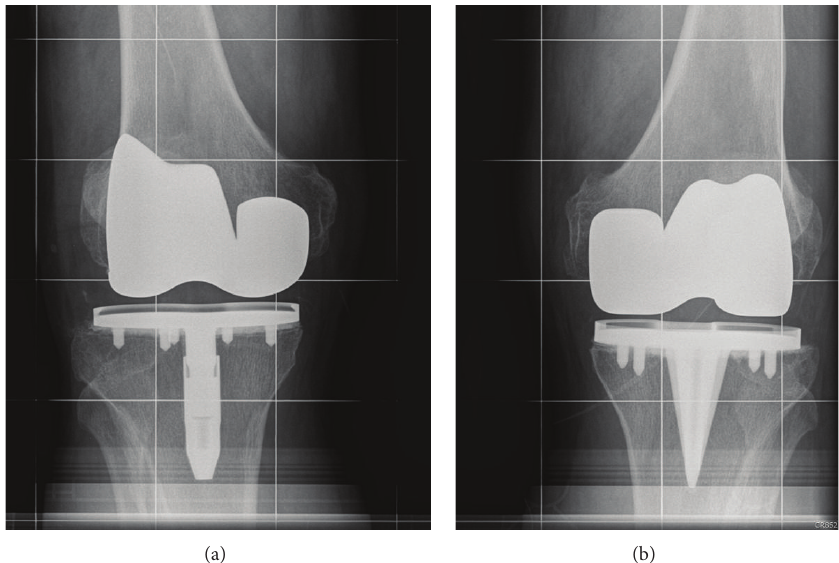
Figure 2: Anteroposterior radiograph of a bilateral TKA patient implanted with (a) the Profix Total Knee System (right knee) and (b) Natural Knee II (left knee) used in the historical control